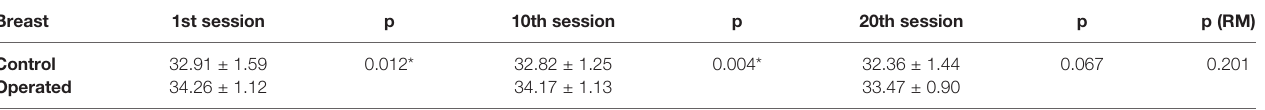
TABLE 2 | Cutaneous temperature in degrees in plastron region and control breast at 1st, 10th, and 20th sessions. Breast